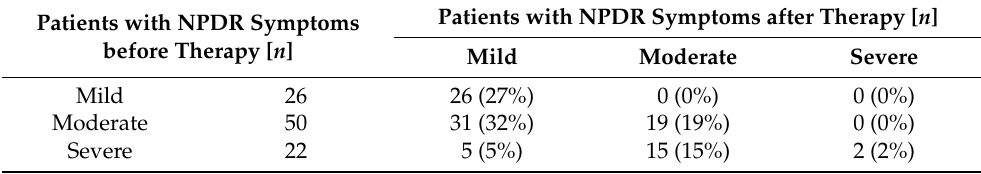
Table 4. NPDR (non-proliferative diabetic retinopathy) severity in patients ( n = 98) with diabetic macular edema (DME) before and after bevacizumab